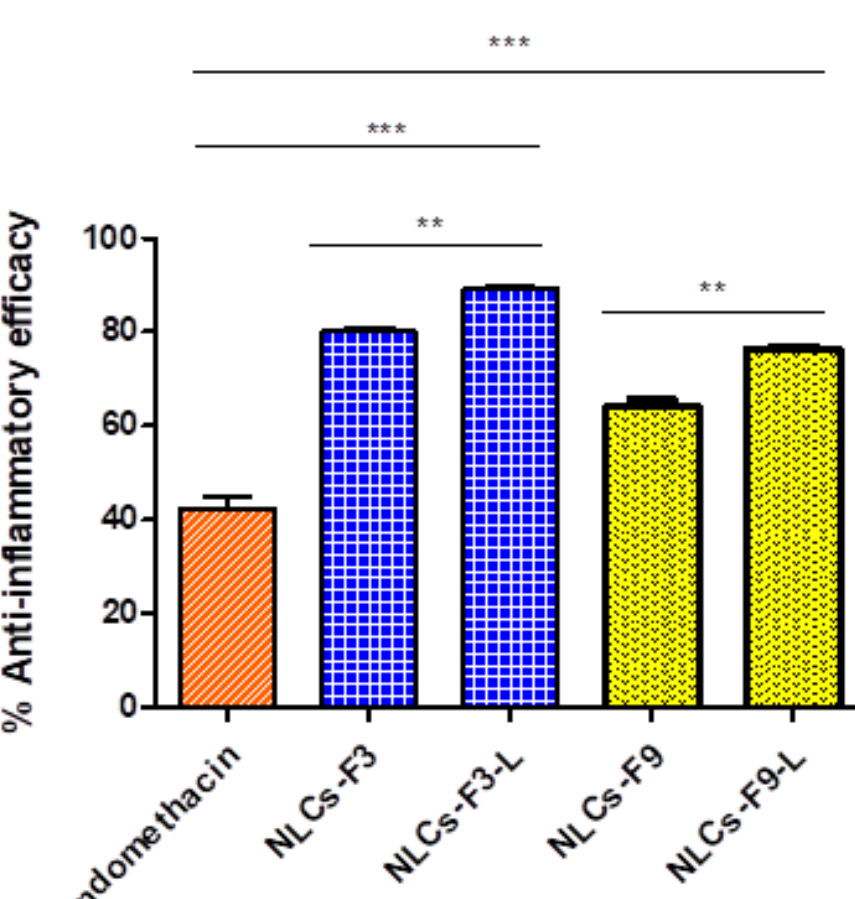
Figure 10. In vivo anti-inflammatory efficacy after TPA (12- O -tetradecanoylphorbol 13-acetate) induced mouse edema. Mean ± SD (n = 6). Significant statistical differences: ** p < 0.01, *** p < 0.001.